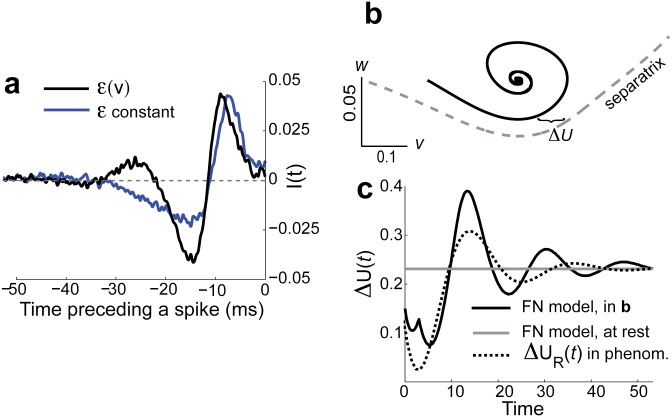
Low dimensional FN model motivates reduced phenomenological model.a) 〈ξ(t)|ts = 0〉 with I(t) = 0 for ν = 0.0045 (D = 0.03 for ε(v)-model and D = 0.069 for ε-model), scaled to have the same maximum [8]. This demonstrates that the neuron prefers input that is hyperpolarizing, quickly followed by depolarizing input. b) The trajectory in the (v, w) phase plane in gray, starting at (v, w) = (−0.2, 0) with I(t) = D = 0. The minimum distance to the separatrix (gray-dashed) in the v direction is ΔU. c) The evolution of ΔU in (b) (solid black), and initial ΔU (gray) are plotted, showing the benefit of hyperpolarizing input. Scaled ΔUR(t) that is used in reduced model (dotted black) is shown for comparison.